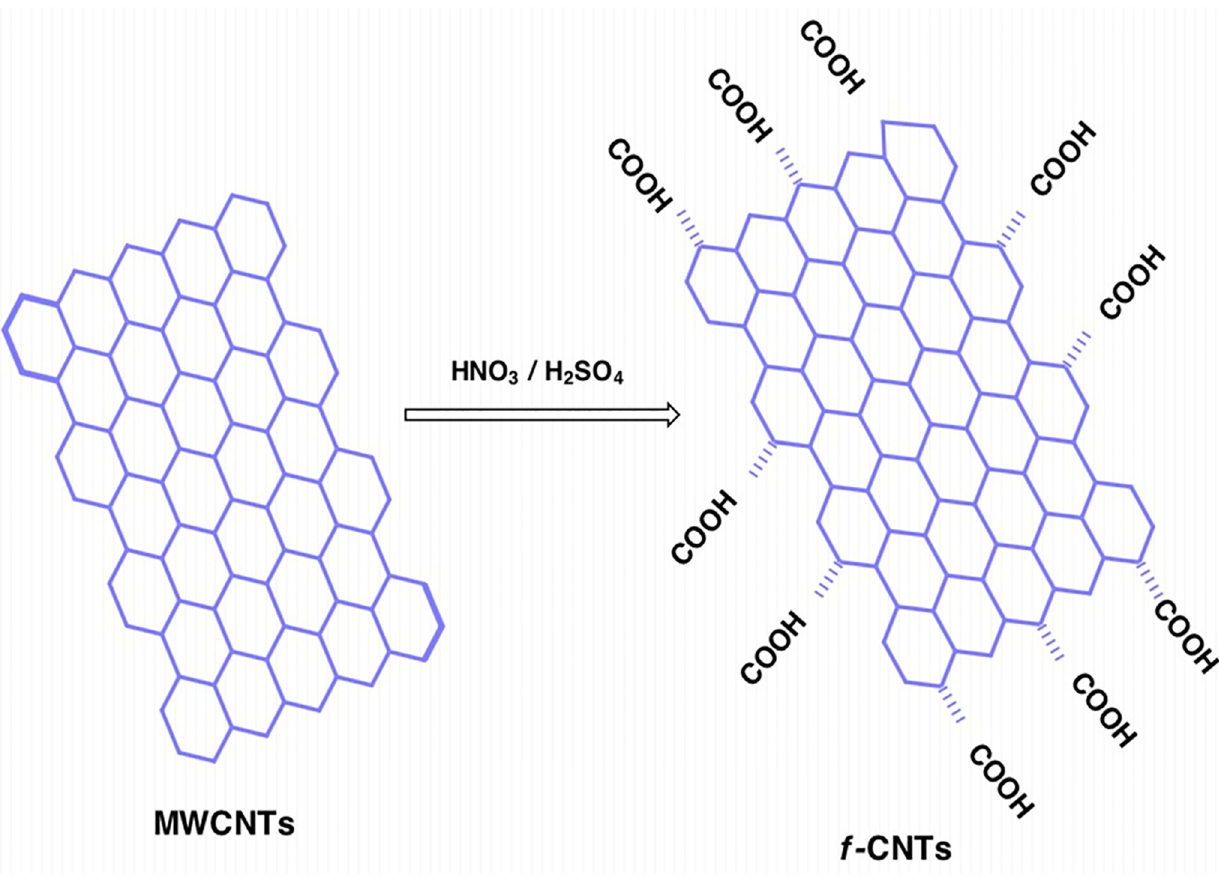
Fig 1. Functionalization reaction of the